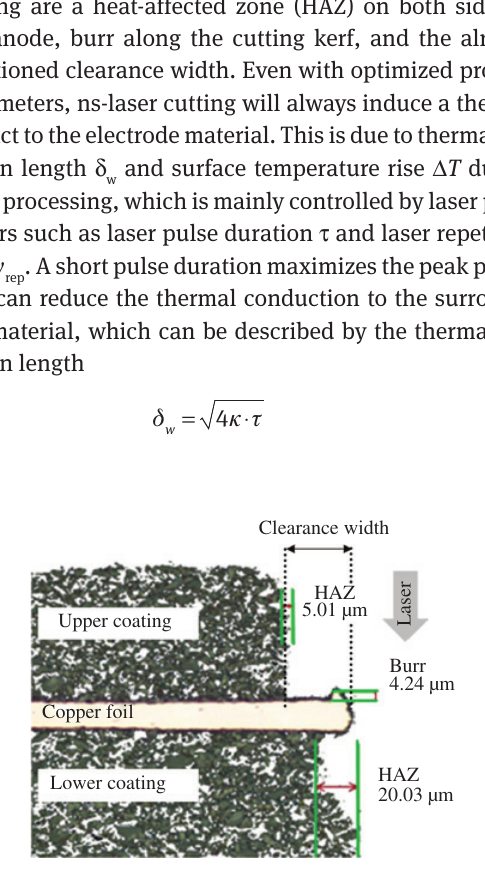
Figure 8: Cross-section view of an anode laser cut edge (laser scan speed 1200 mm/s, laser wavelength 1064 nm, average laser power 100 W). Reprinted from